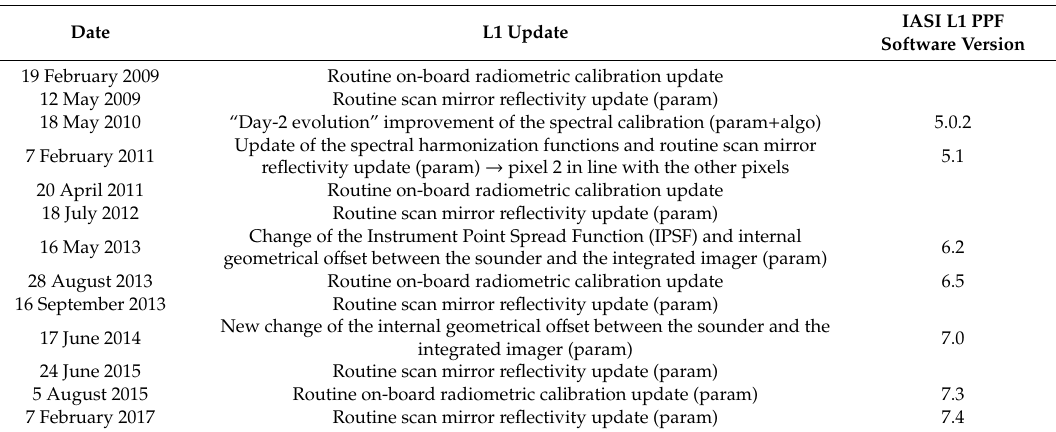
Table 1. List of IASI-A L1 processing